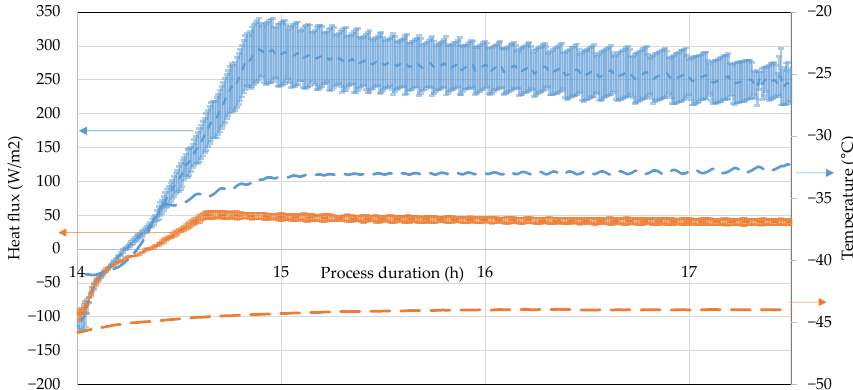
T_p −25 C 0.05 mbar Figure 15. Heat flow and product temperature are based on different process